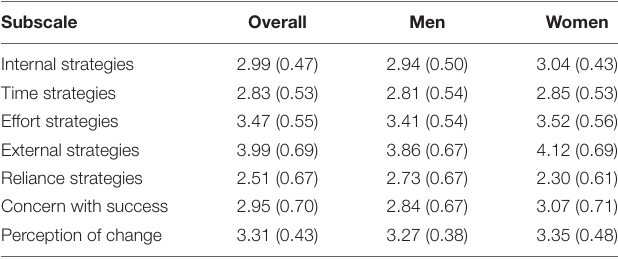
TABLE 2 | Scores on MCQ subscales, reported by participant